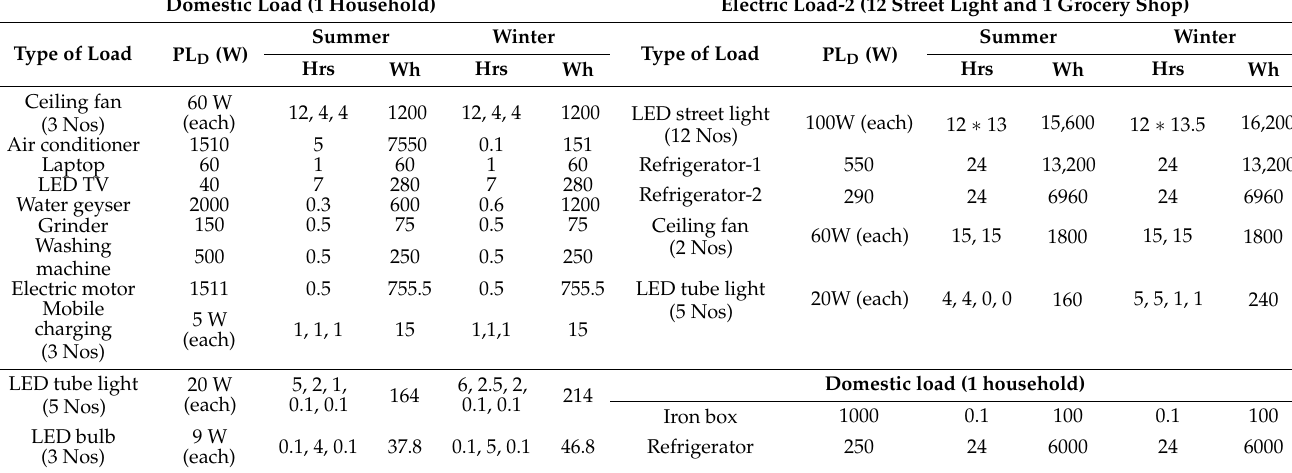
Table 3. Average daily consumption for domestic load and electric load-2 during summer and winter seasons of Kalpeni Island.